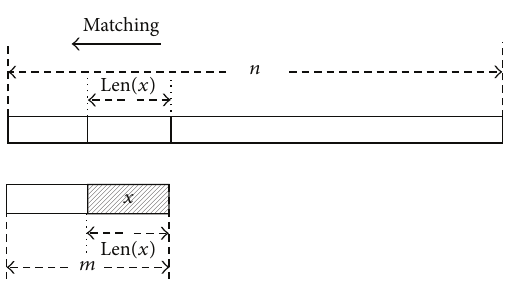
Figure 6: Matching the substring of pattern from